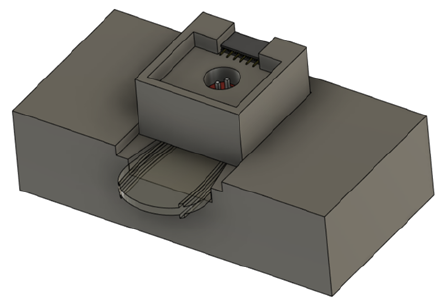
Figure 4. Mechanical design for a more compact minilysis on the platform of Fusion 360